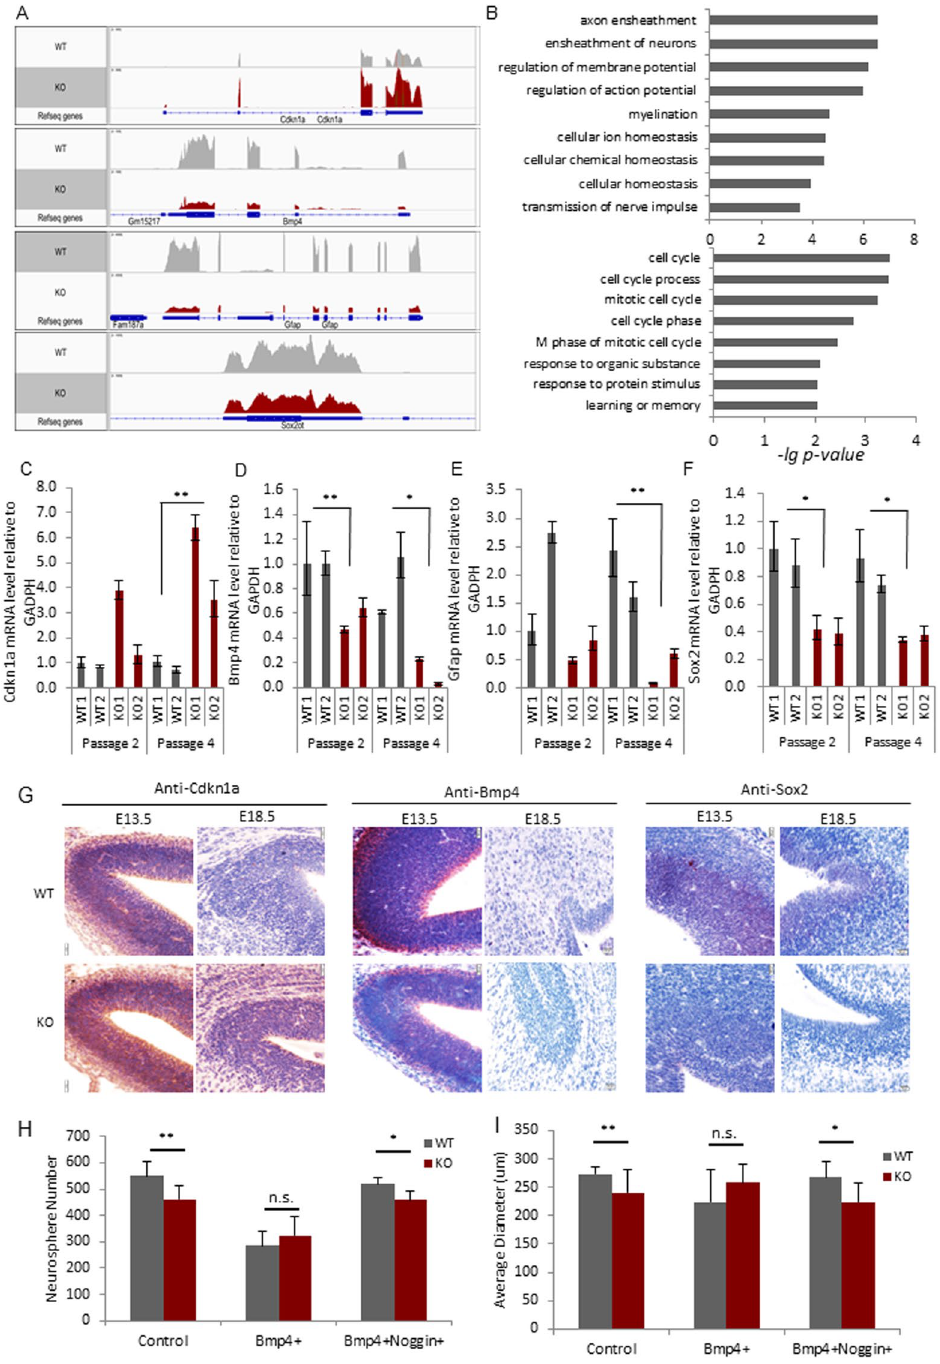
Figure 3. Altered Bmp4 and Cdkn1a expression in the absence of Lsh. ( A ) Profiles of RNA-seq reads at specific genomic regions: Cdkn1a, Bmp4, Gfap and Sox2 (the Sox2ot transcript (chr3: 34,459,303–34,576,915) encompasses the Sox2 transcript (chr3: 34,548,927–34,551,382) –the graph shows the read numbers of the Sox2 gene and the coding region is represented in blue boxes at the top of the figure) ( B ). Gene Ontology (GO) analysis of genes down-regulated (upper panel) or up-regulated (lower panel) in Lsh − / − NSCs. X-axis represents negative lg p -values. See also Fig. S3. ( C , D , E and F ) Validation of gene expression changes by RT- qPCR: Cdkn1a ( C ), Bmp4 ( D ), Gfap ( E ) and Sox2 ( F ). ( G ) IHC assay on different development stage embryonic brain sections (n = 4) using anti-Bmp4 (E13.5), anti-Sox2 (E13.5) and anti-Cdkn1a (E13.5 and E18.5) antibodies. ( H and I ) Quantification analysis of neurosphere numbers ( H ) and average diameters ( I ) in WT and KO NSPCs upon addition of exogenous Bmp4. Noggin was used as antagonist of Bmp4 to reverse Bmp4 effects. (3 WT and 3 KO embryos were used, 3 technical repeats for each sample). See also Fig. S2. Gapdh served as internal control, expression levels were relative to WT1 for each gene. Error bars represent SD. Scale bar, 20 μ m. * p < 0.05, ** p <